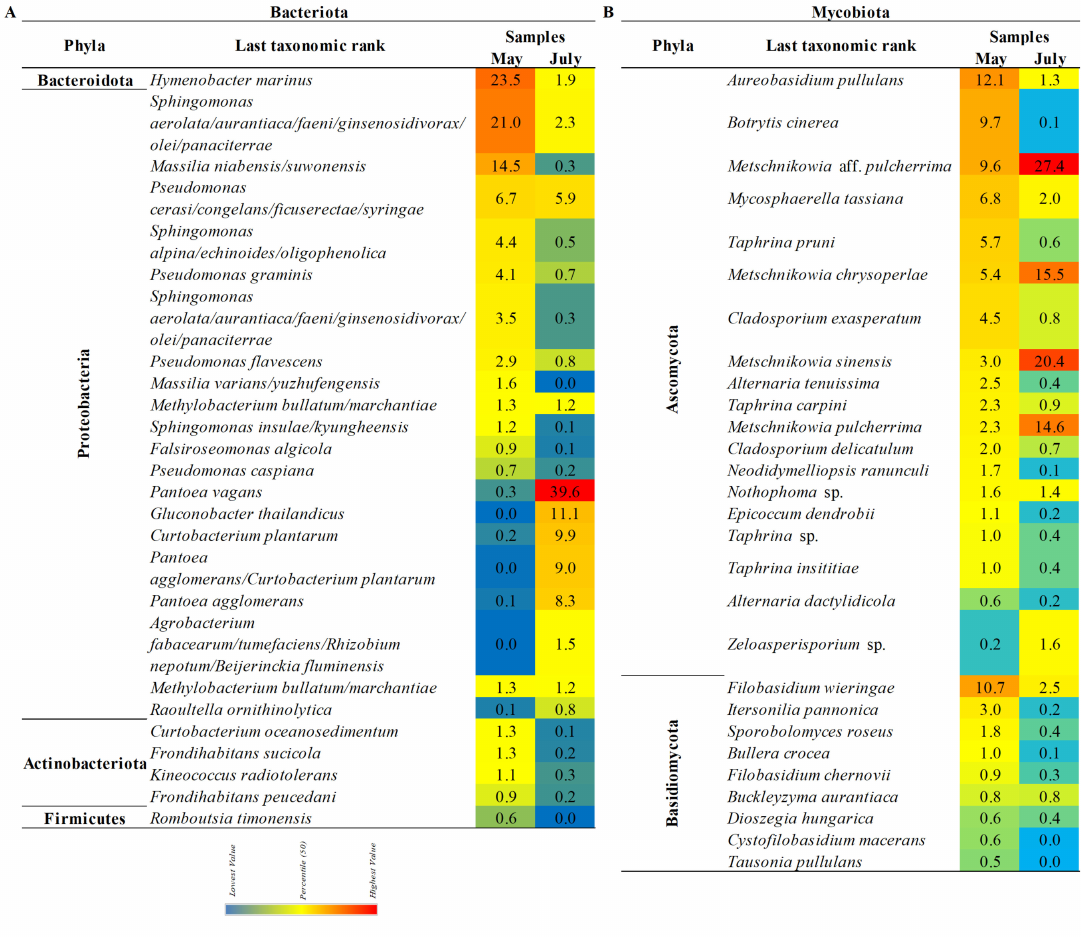
Figure 4. Relative abundance (RA) of bacterial ( A ) and fungal ( B ) species associated with the ‘Williams’ pear variety at two phenological stages. Species with a total RA above 0.5% are